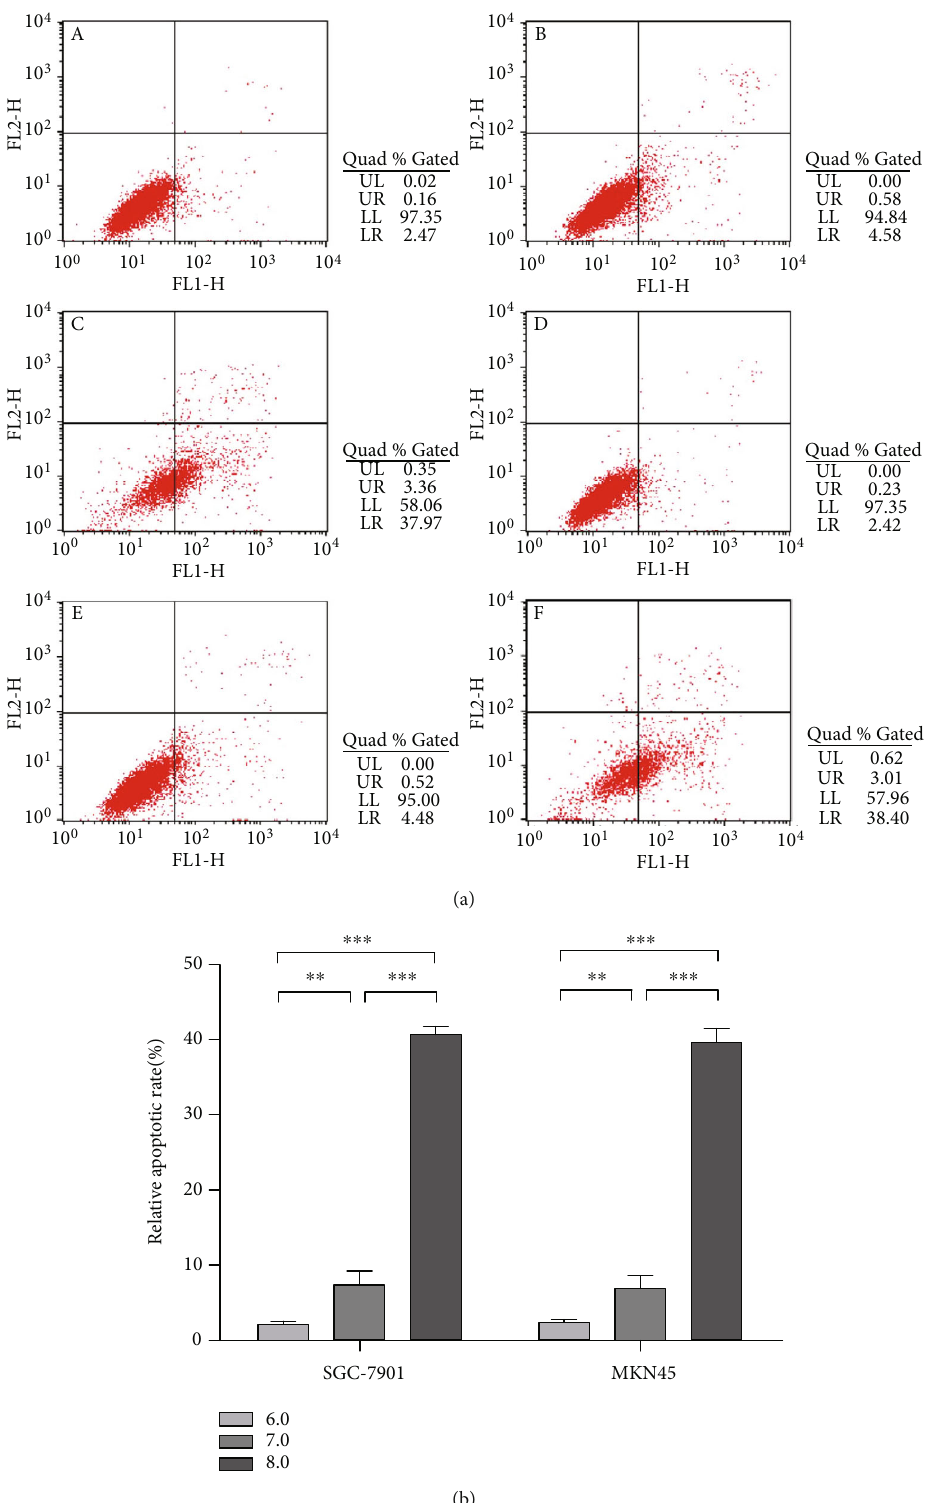
Figure 2: Alkaline microenvironment promoted the apoptosis of GC cells. (a) Apoptosis of GC cells at di ff erent pH values (pH6.0, pH 7.0, and pH 8.0) after being cultured for 48h. A, B, and C in (a), respectively, represented apoptosis of SGC-7901 cultured in a medium with pH 6.0, pH7.0, and pH 8.0 for 48h, respectively; D, E, and F represented apoptosis of MKN45 cultured in a medium at pH 6.0, pH 7.0, and pH 8.0 for 48h, respectively. (b) Apoptosis results of GC cells (SGC-7901 and MKN45) at media of di ff erent pH values (pH6.0, pH 7.0, and pH8.0) after being cultured for 48